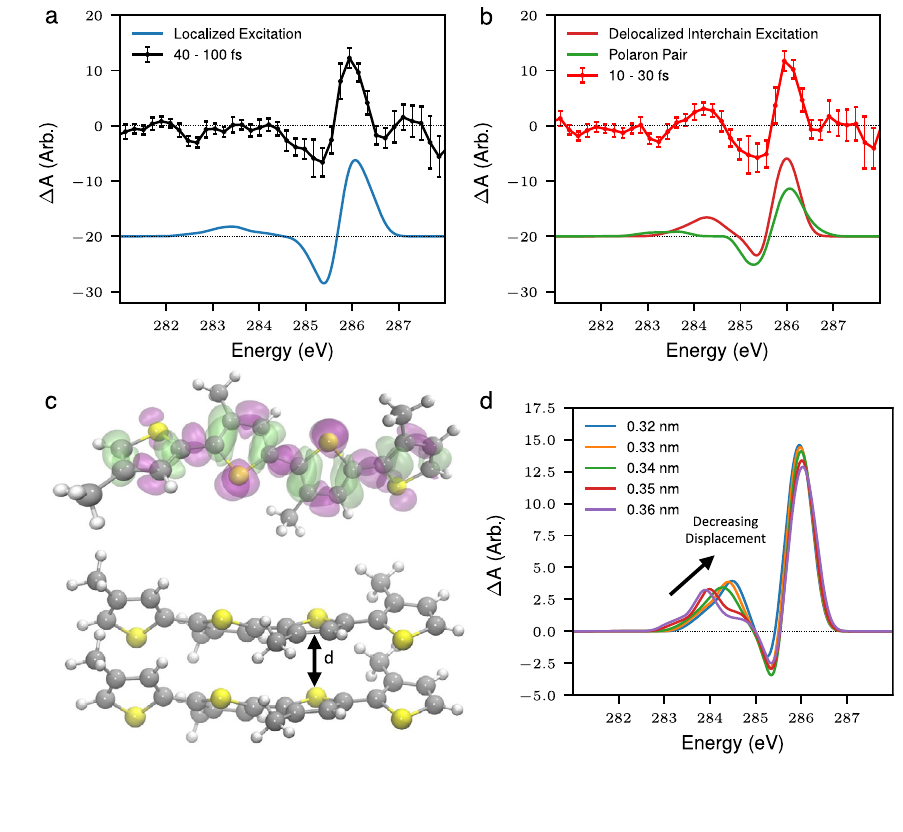
Fig. 3 Calculated X-ray absorption spectra for excited state species in P3HT. a Comparison of the differential absorption signal at between 40 and 100 fs with the theoretical prediction for a tetrathiophene oligomer which approximates the singlet exciton localized on a single polymer chain. b A comparison between the differential absorption signal at short time delays (10 – 30 fs) and the theoretical differential absorption spectrum for a tetrathiophene oligomer dimer, which approximates a delocalized interchain excitation the aggregated polymer and a constrained cationic – anionic tetrathiophene oligomer dimer, which models a polaron pair in the polymer. The error bars in the experimental traces shown in ( a , b ) correspond to ±1 standard error. Further details can be found in the methods section. c The electron density difference between the simulated ground and excited states in the tetrathiophene oligomer, purple indicates a loss of electron density and green indicates a gain indicating that there is a transfer of electrons from the green regions to the purple regions in the excited state relative to the ground state. Below is a ball and stick model of the simulated tetrathiophene oligomer dimer, showing the π stacking distance, d. d The simulated differential absorption spectrum for the tetrathiophene oligomer dimer as a function of π stacking distance. Transitions above 286 eV are above the ionization potential. As we have used atomic centered Gaussian basis sets, we expect these transitions around the continuum to be unconverged and therefore have not included a description of the nature of these features in the